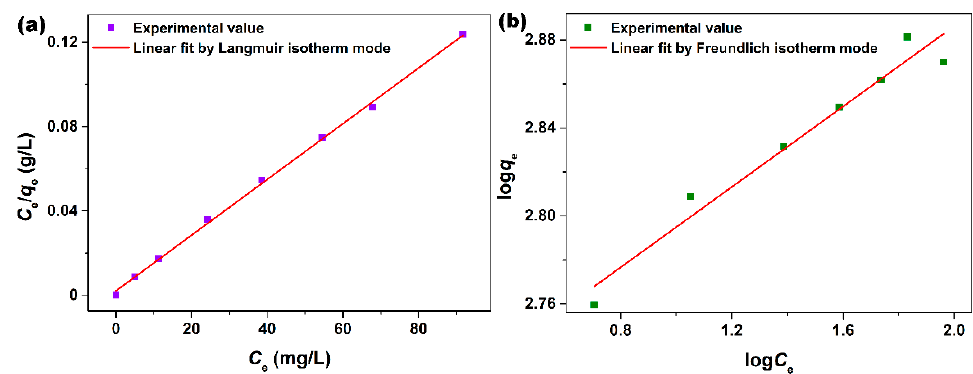
Figure 5. ( a ) Langmuir and ( b ) Freundlich linear fittings of AO7 molecule onto mesoporous CeO 2 synthesized hydrothermally at 140 °C for 24 h with 10 mL H 2 O 2 .